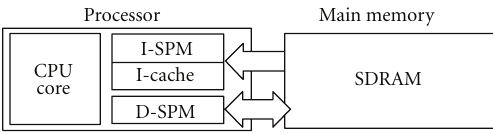
Figure 1: A target processor system